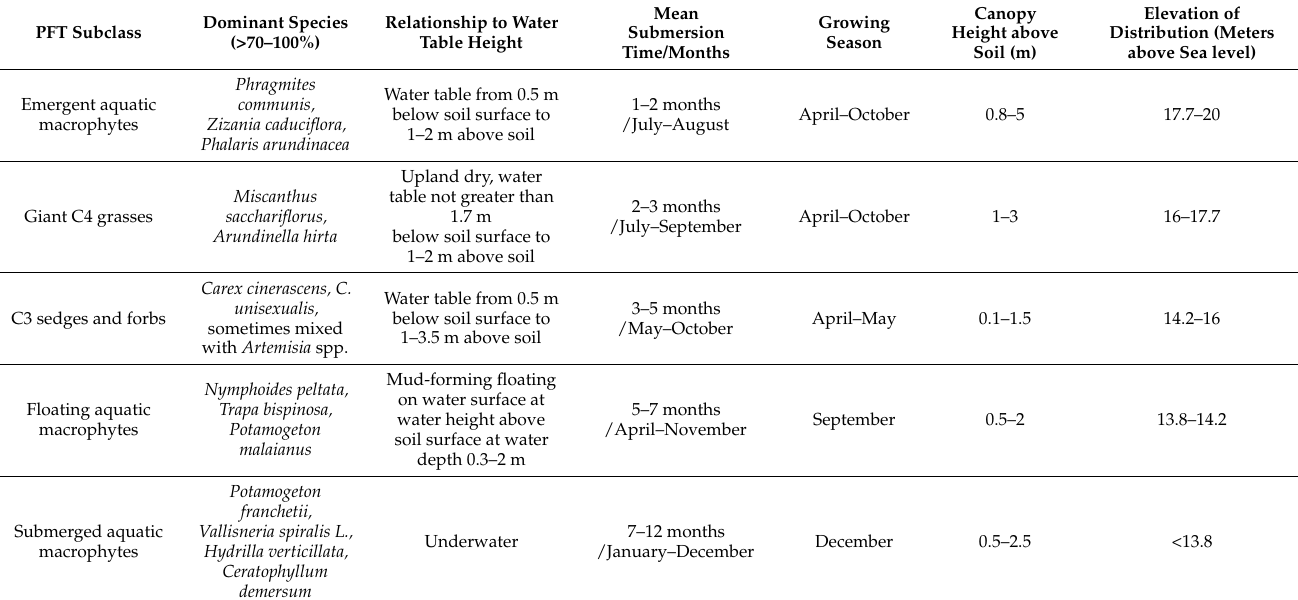
Table 2. Plant functional type classification system for Poyang Lake.